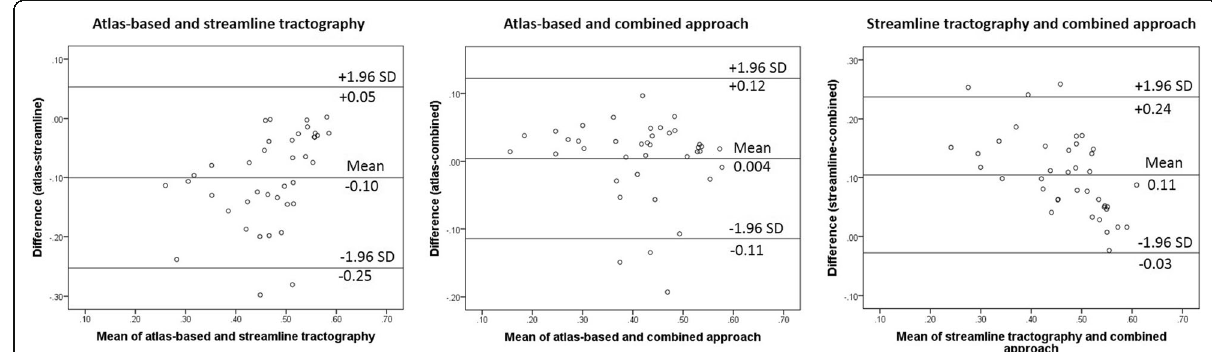
Fig. 4 Bland-Altman plots showing the comparisons between approaches. SD , standard